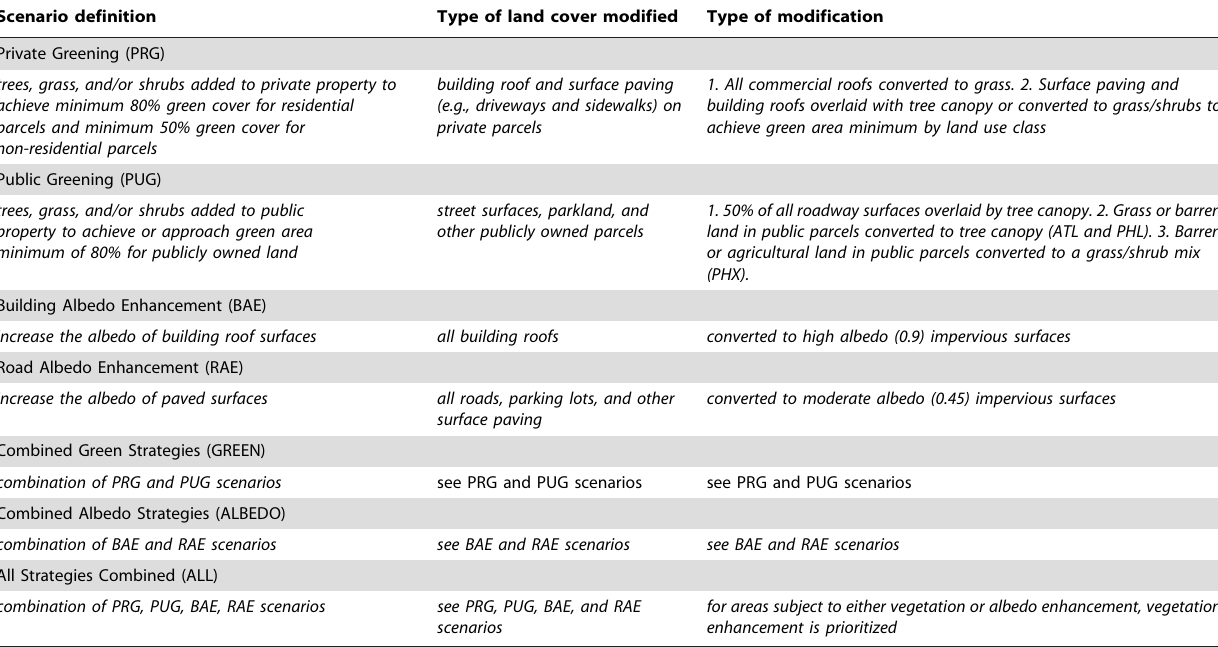
Table 1. Description of 2050 heat management WRF